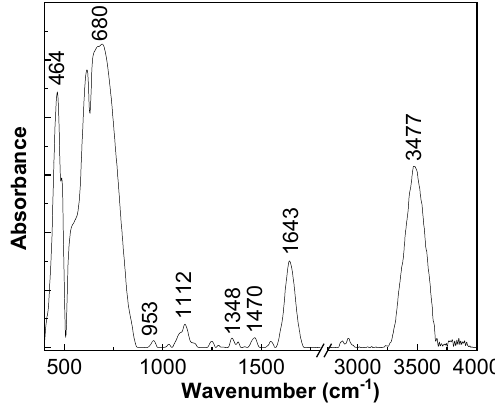
Figure 2. Infrared spectrum of the sample.